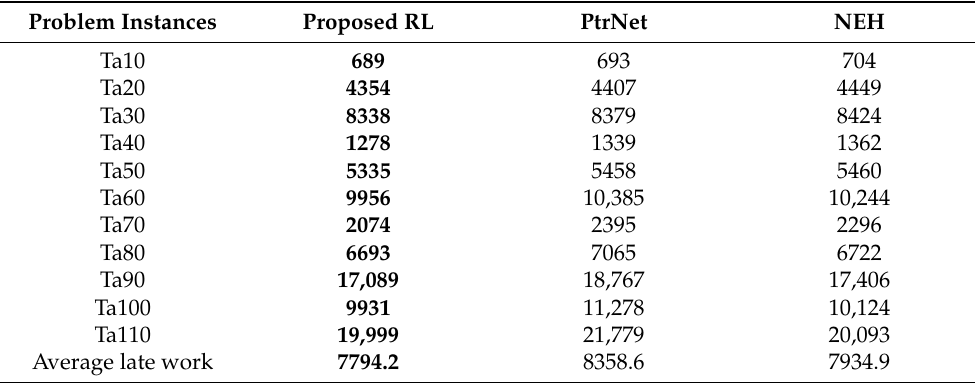
Table 8. Results achieved by Proposed RL, PtrNet, and NEH.